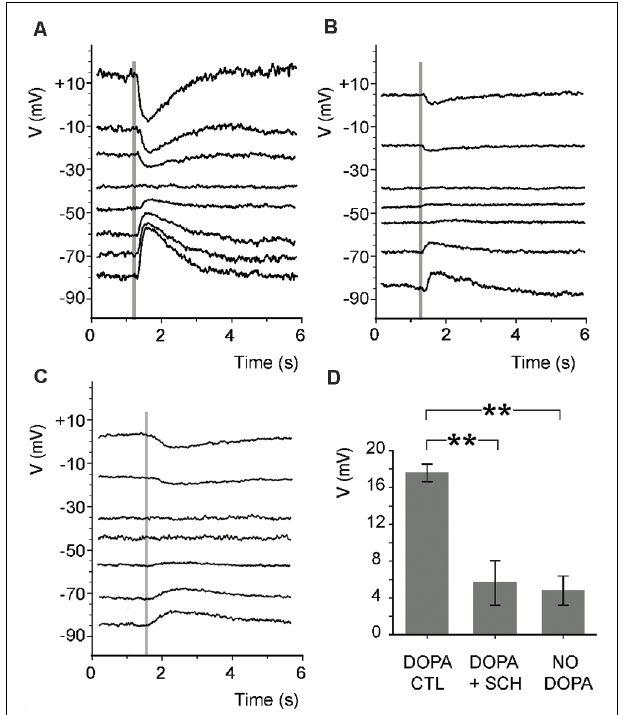
FIGURE 4 | Endogenous activation of ON-cBC D 1 Rs leads to GABA A R activity of ON-cBC dendrites.In rabbit retinal slices superfused with Ames medium containing dopamine (5 µ M), TPMPA (50 µ M), a GABA C R antagonist, and cobalt (2 mM) to block synaptic transmission, GABA (0.5 mM) was puffed onto BC dendrites (time of puff is indicated by shaded vertical lines) by pressure ejection. GABA responses were clearly evident under dopamine (control) conditions (A) with an average GABA reversal potential (E GABA ) = − 42.2 + 2.6 (SEM) mV ( n = 5), but were much reduced by SCH (5 µ M) (B) and when the superfusate did not contain dopamine (C) . (D) When GABA was puffed at − 70 mV, average peak GABA A R response size was significantly greater (** p < 0.01) when the superfusate contained dopamine (DOPA CTL; 17.6 + 1 mV; n = 5) compared to when it contained dopamine and SCH (DOPA + SCH; 5.6 + 2.4 mV; n = 5) or did not contain dopamine (NO DOPA; 4.8 + 1.6 mV; n = 5). Modified from Chaffiol et al. (2017).